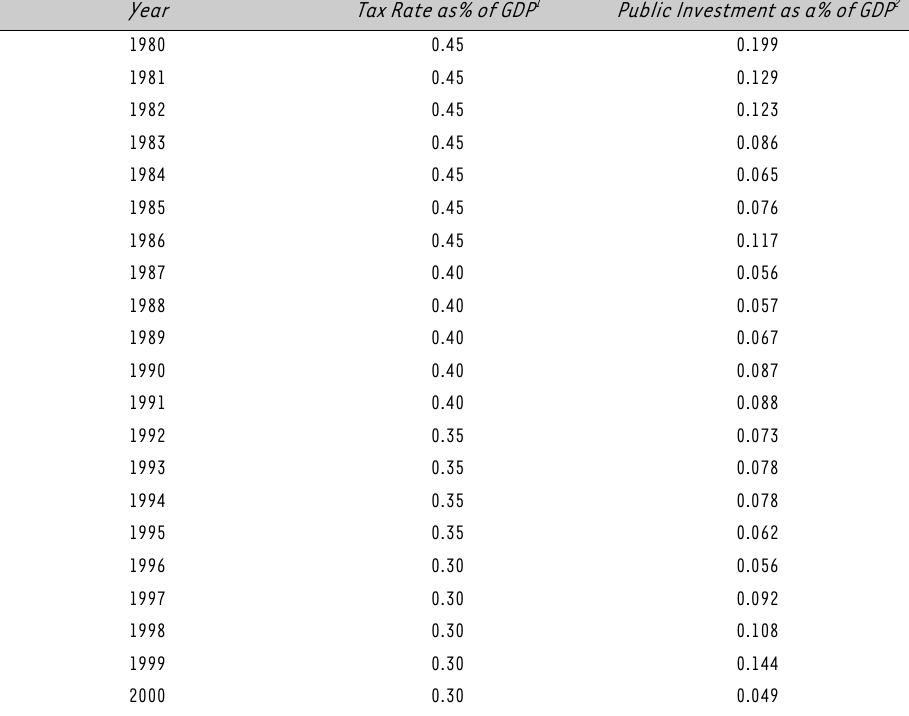
Tax rate and public investment as a percentage of